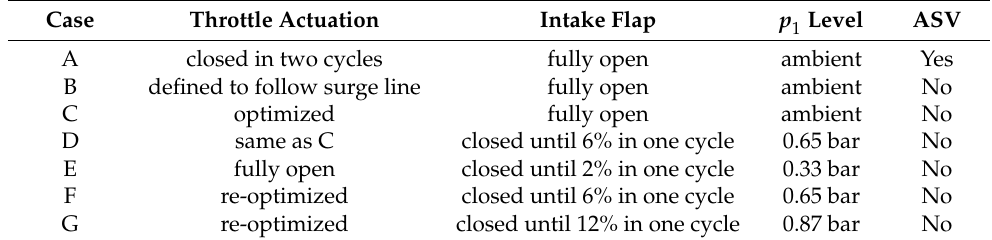
Table 2. Summary of the main features of Case A, B, C, D, E, F and G.